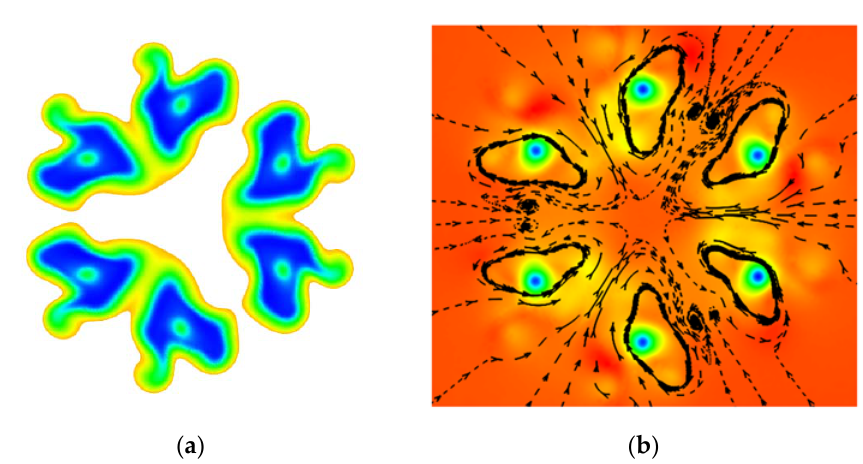
Figure 8. Cloud map of lateral flow characteristics for 3 kg load working condition at different heights: ( a ) Velocity distribution at z = 1.426 m; ( b ) Streamline diagram on the background of pressure at z = 0.926 m.